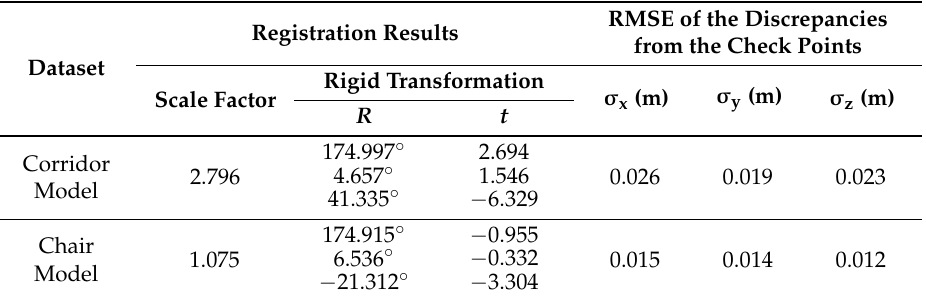
Figure 8. False matches rejection for corridor model. Table 4. Statistics on discrepancies in the object space between the model from depth and RGB images.